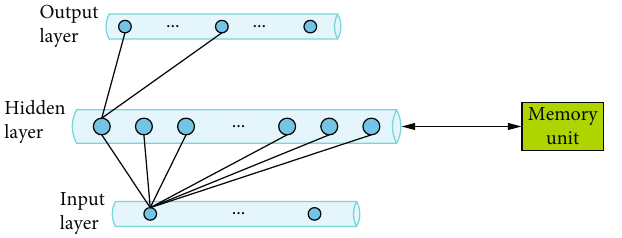
Figure 3: Recurrent neural